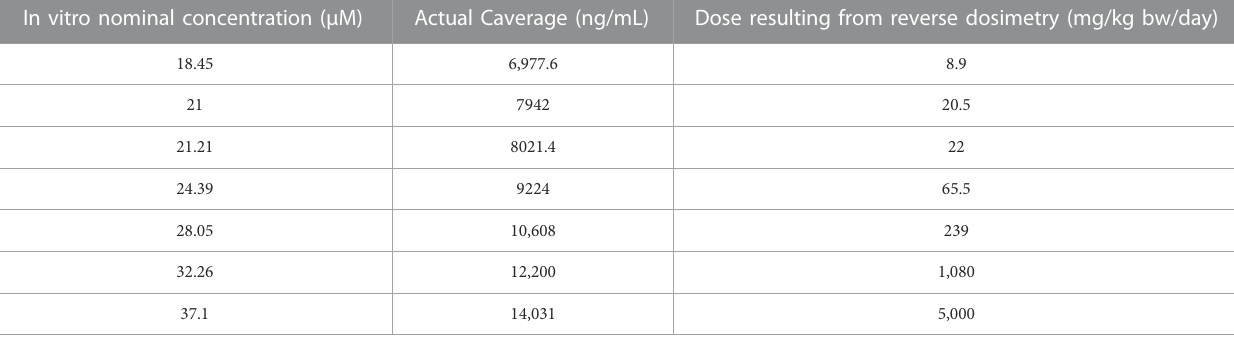
TABLE 2 In vitro actual cellular average CPF concentrations in cultured human NSCs undergoing differentiation towards neurons and glia, corresponding to the nominal dosing levels (data taken from (Di Consiglio et al., 2020) and in vivo oral maternal doses obtained by reverse dosimetry. In vitro nominal concentration (µM)